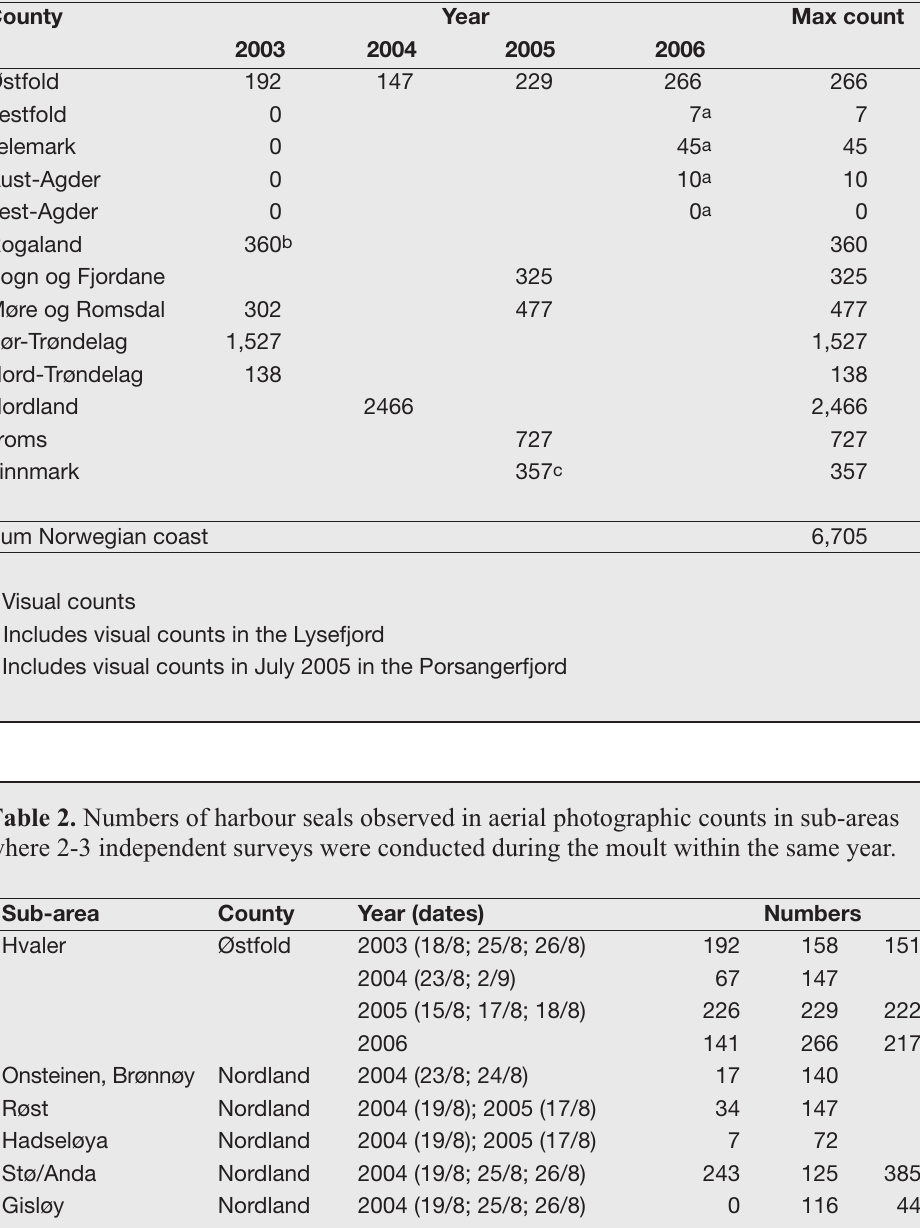
Table 1. Minimum numbers of harbour seals in each county along the Norwegian coast based on aerial photo surveys and visual counts during the moult (August-September) in